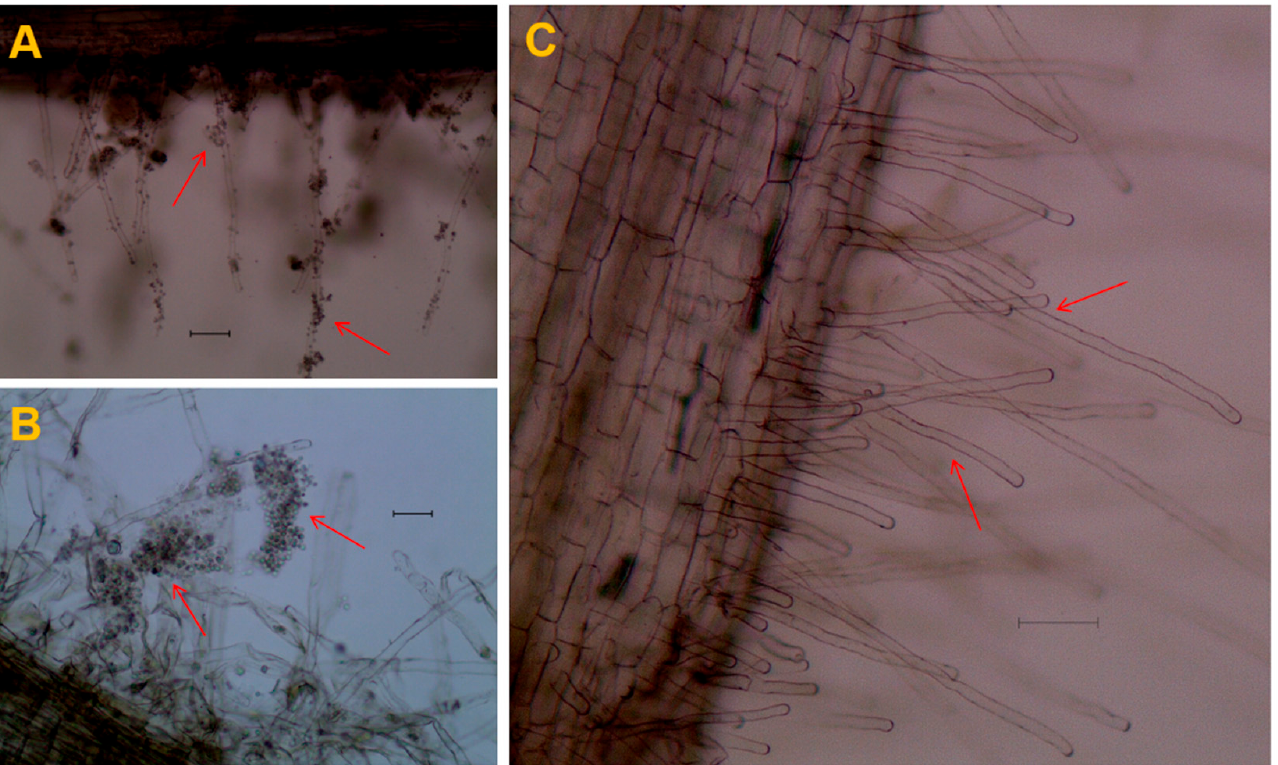
Figure 1. Confocal microscopy micrographs of marigold roots inoculated with Plasmodiophora brassicae resting spores. ( A , B ); Inoculated with 100 µ L/tube of P. brassicae spore suspension (1 × 10 7 spores/mL) and ( C ); inoculated with sdH 2 O 100 µ L/tube as control. Red arrows show the germination of P. brassicae spores after 24 h post-inoculation ( A ), 7 days post-inoculation ( B ), and with no spores ( C ). Bars represent 50 µ M.